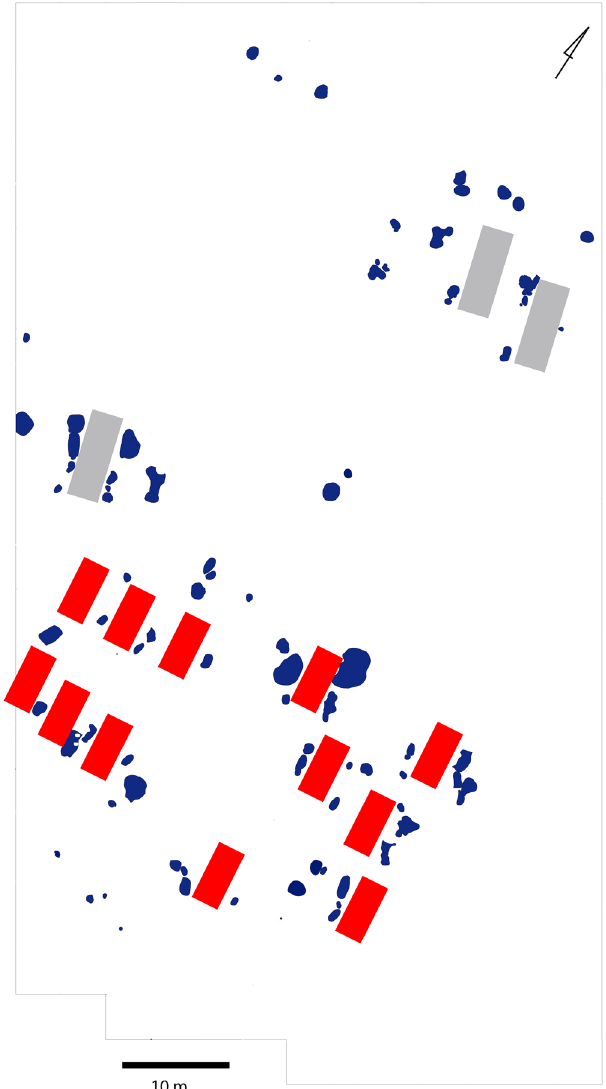
Figure 4: LBK settlement at Kruszyn 10. Blue – LBK pits, red – LBK houses, grey – hypothetical LBK houses. After Sici ń ski, P ł aza, & Papiernik, 2016, modi fi